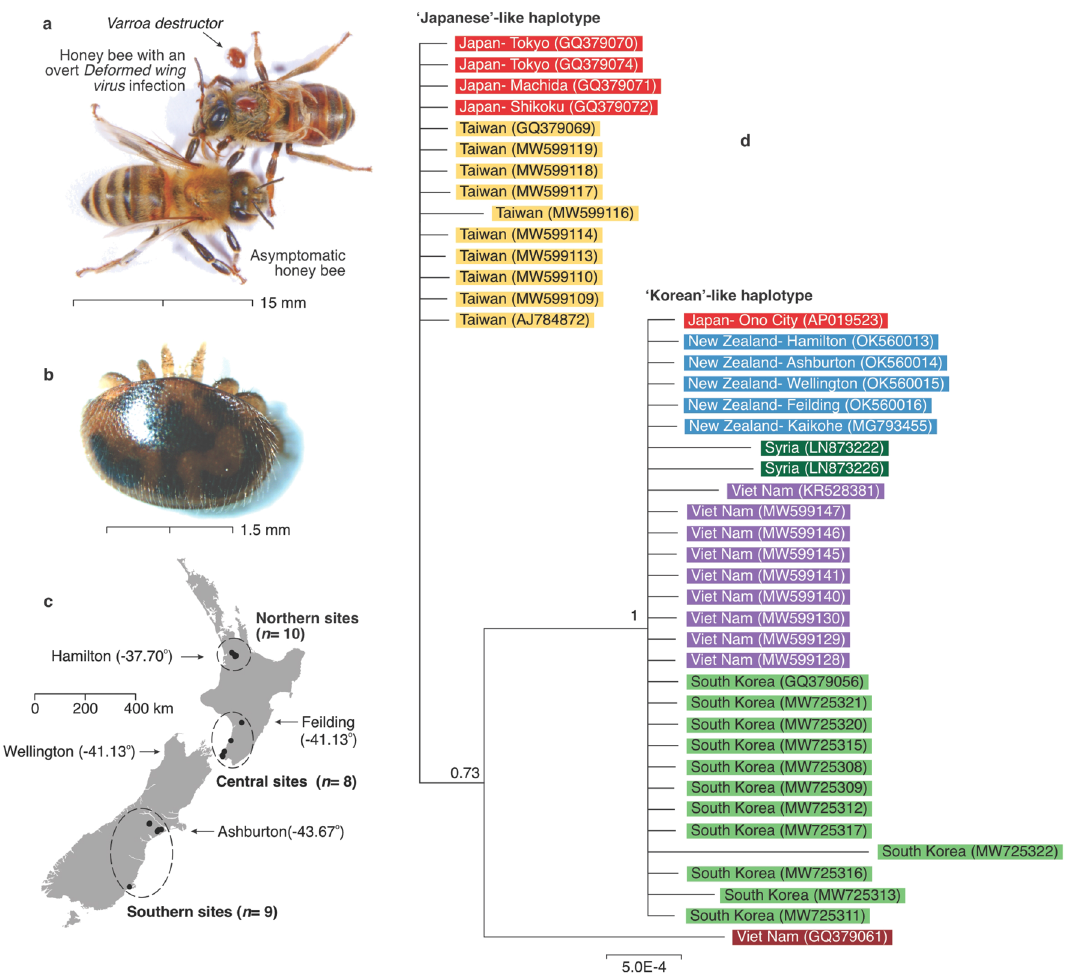
Figure 1. ( a ) A Western honey bee ( Apis mellifera ) showing an overt Deformed wing virus (DWV) infection, with V. destructor mites, and another bee asymptomatic for this virus. ( b ) Varroa destructor mites were